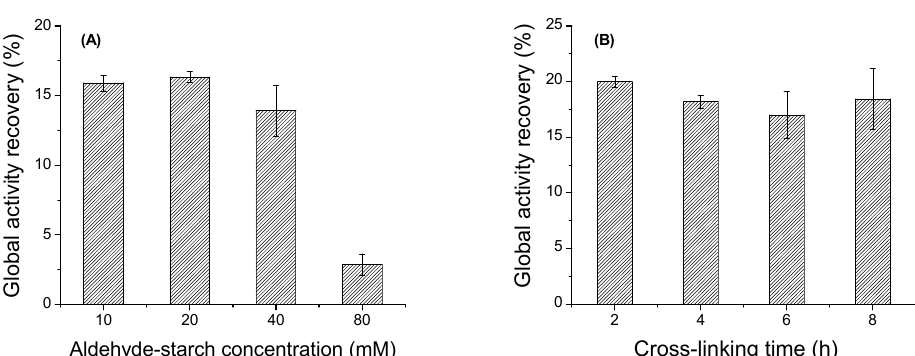
Figure 5. ( A ) Influence of aldehyde–starch concentration and ( B ) effect of the cross-linking time (20 mM aldehyde–starch in the presence of 1 mg/mL maltose) on the global activity recovery of CGTase CLEAs. Reaction conditions: enzyme solution prepared in 50 mM sodium citrate buffer pH 6.0, precipitation with acetone (75% volumetric concentration, 20 °C, 1 h); crosslinking at 20 °C for 3 h under 200 rpm stirring; reduction with sodium borohydride (1 mg/mL, 30 min, 4 °C).